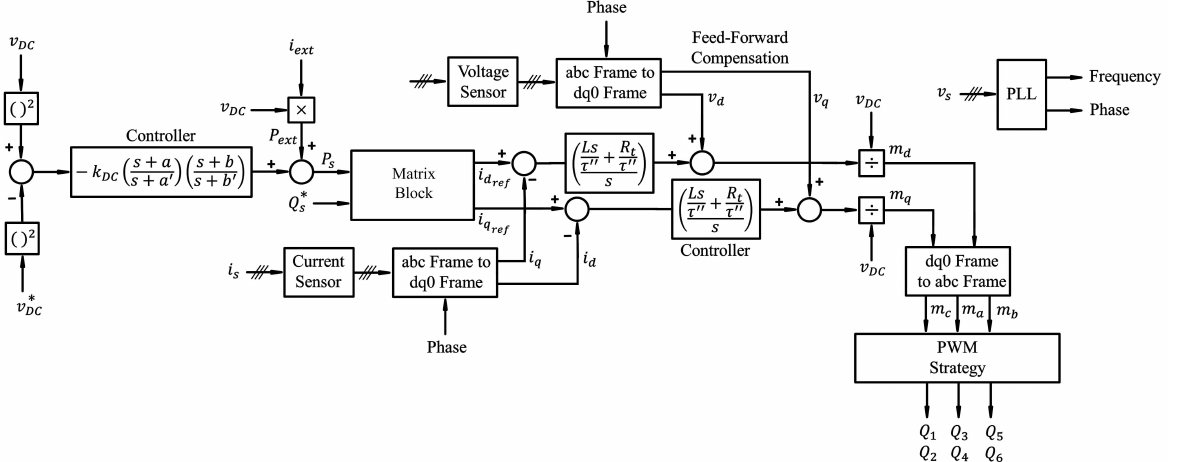
Figure 3. Detailed description of the control block diagrams of the DC-AC part depicted in Figure 1.